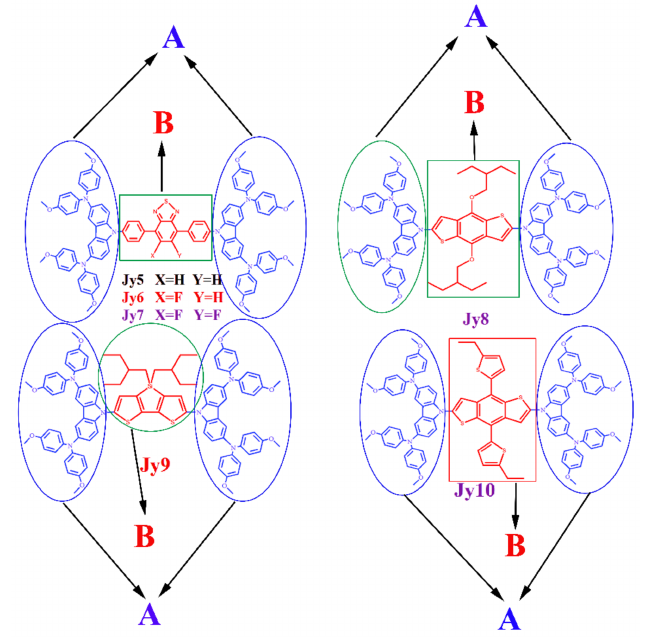
Figure 2. The fragment’s definitions of six investigated